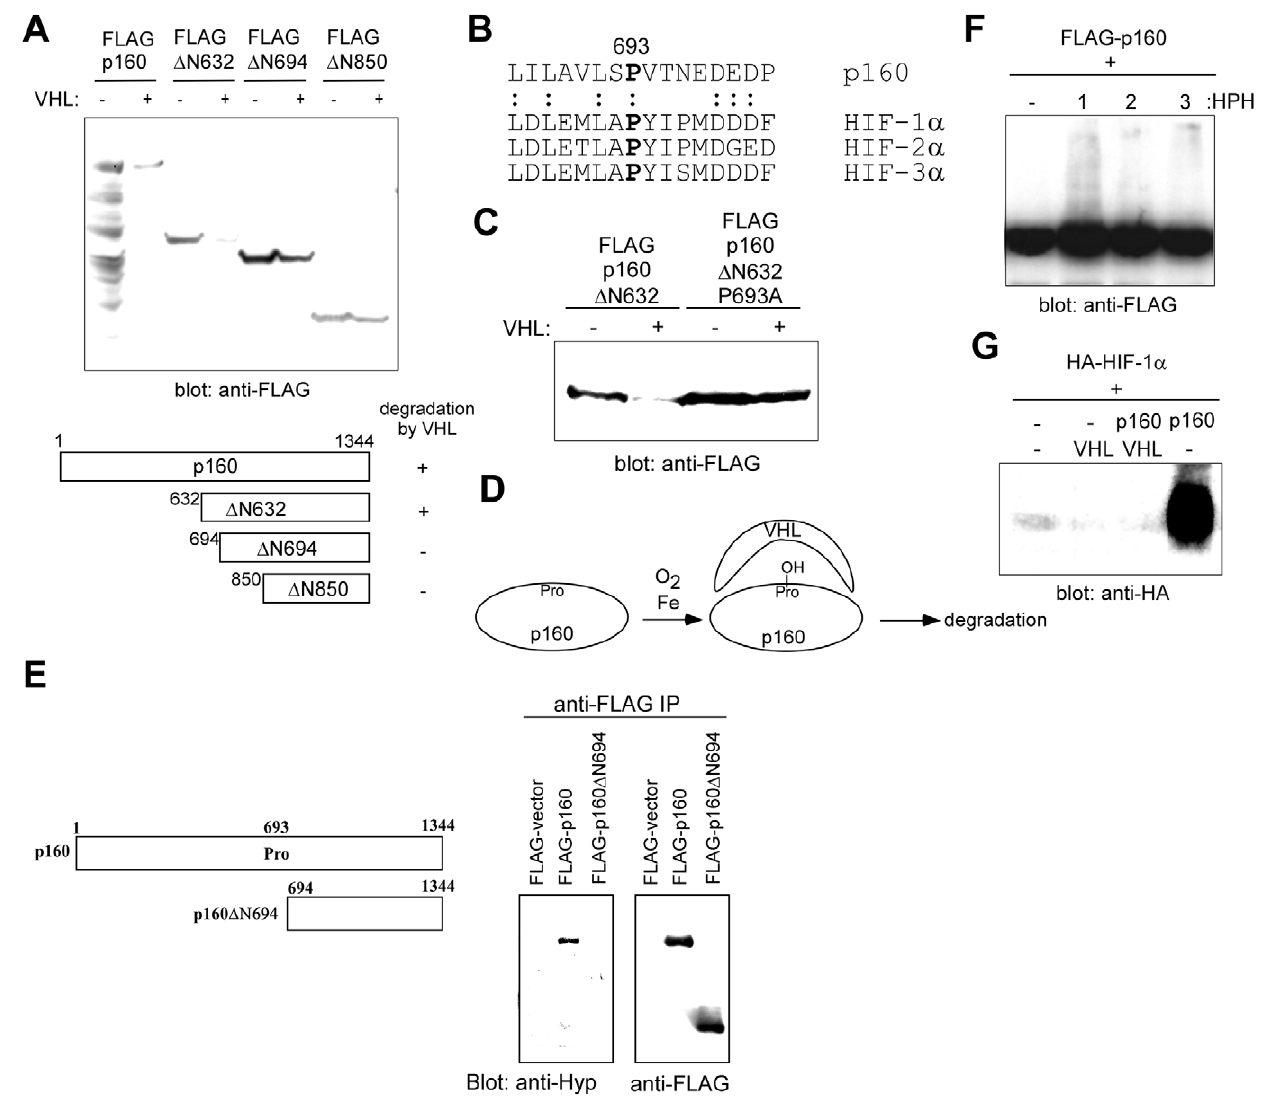
Figure 4. Mechanism of p160 degradation by VHL. (A) Deletion mapping of the p160 degron. A series of N-terminal p160 deletion mutants (diagram shown below) was analyzed for their sensitivity to VHL-mediated degradation in transfected 293T cells by immunoblotting. (B) p160 has a motif similar to the one surrounding the hydroxylated proline in HIFs. Alignment of p160 amino acid 686-701 and the C-terminal oxygen-dependent degradation domain (ODD) of HIF-1 a , HIF-2 a , and HIF-3 a is shown. (C) Proline 693 is critical for degradation of p160 by VHL. The effect of co- transfection of VHL on FLAG-p160 D N632 or FLAG-p160 D N632P693A was analyzed in 293T cells. Whereas p160 D N632 was efficiently degraded by VHL, mutation of proline 693 to alanine abolished degradation by VHL. (D) Model for the degradation of p160 by VHL. (E) Prolyl hydroxylation of p160. FLAG-p160 or FLAG-p160 D N694 was transfected into 293T cells and was analyzed by anti-FLAG immunoprecipitation followed by anti- hydroxyproline or anti-FLAG immunoblotting. (F) Effect of prolyl hydroxylases on p160. 293T cells were transfected with FLAG-p160 alone or in conjunction with HIF prolyl hydroxylase HPH1, 2, or 3, and p160 expression was analyzed by anti-FLAG immunoblotting using 30 m g whole cell lysate. (G) Stabilization of HIF-1 a by p160. 293T cells were transfected with HA-HIF-1 a alone or together with p160 and/or VHL as indicated and the